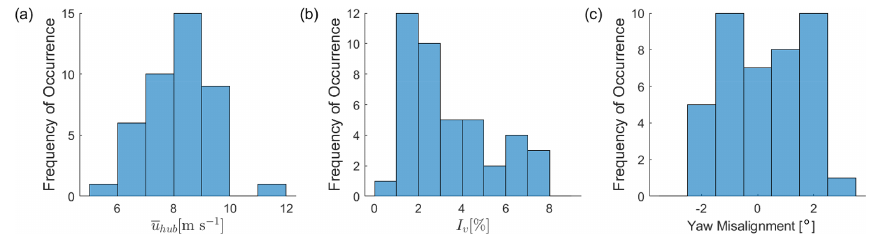
Figure 4. Distribution of the mean wind speed at hub height from the SCADA data (a) , the lateral turbulence intensity from the laterally staring Doppler lidar (b) , and the mean yaw misalignment of the wind turbine from the SCADA data (c)